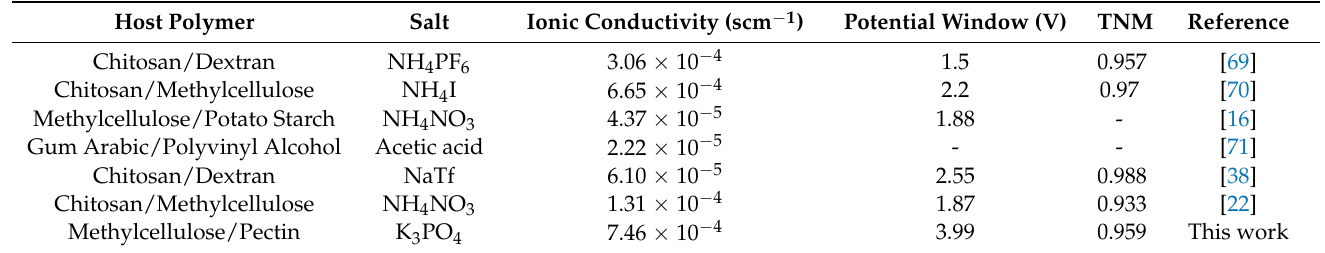
Table 5. Comparison of electrochemical performance of some glycerol-plasticized biopolymer-based SPEs.